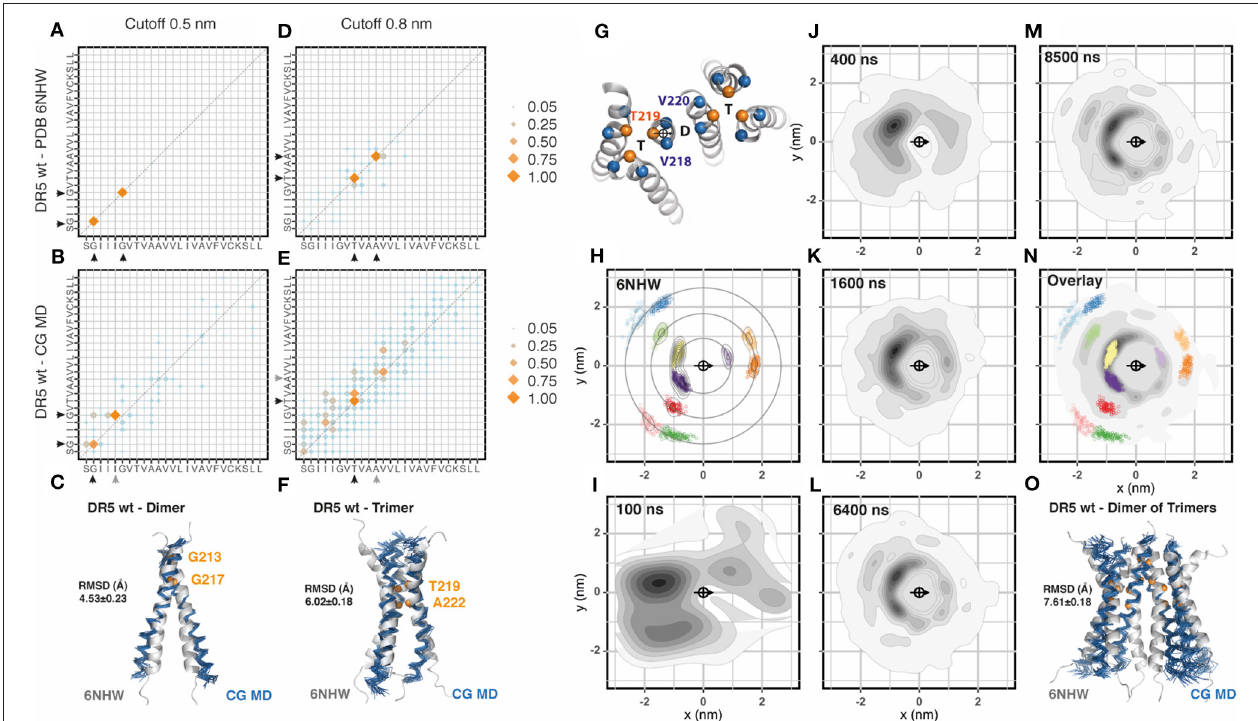
FIGURE 3 | DR5 assembly (A) . Contact matrix of DR5 NMR (PDB:6nhw) at 0.5nm cut-off distance. The amino acid sequence corresponds to residues S212 to L236. Black arrowheads indicate the residues involved in these interactions (GxxxG motif). Data corresponds to the averaged 15 NMR models. Scale corresponds to the number of contacts normalized to the most frequent one. (B) Same as (A) , for DR5 coarse grained molecular dynamic (CG-MD) simulations. Black arrowheads indicate conserved interactions whereas gray arrowheads indicate non-conserved interactions. The analysis was performed on the full system (36 × 36) between 3 and 8 µ s. (C) Alignment of DR5 NMR average dimer with a DR5 CG-MD dimer, together with the analysis of the averaged root mean square deviation (RMSD) of the alignment. (D) Same as (A) , but using a cut-off distance of 0.8nm. (E) Same as (B) , but using a cut-off distance of 0.8nm. (F) Alignment of DR5 NMR average model with a DR5 CG-MD trimer, together with the analysis of the averaged root mean square deviation (RMSD) of the alignment. (G) Residues chosen for the centroid and orientation vector used for radial distribution analysis. (H) Radial distribution analysis of coarse grained DR5 NMR structure 6nhw. Note that it is possible to identify dimers, trimers, and higher order assemblies in consecutive orbits. Scale corresponds to the 2D-density function from the scatter plot, as described in Methods. (I–M) Radial distribution analysis of different snapshots of DR5 CG-MD at the indicated time points. (N) Overlay of the radial distribution of the reference structure (6nhw, color dots) and the CG-MD structures (gray density scale). (O) Alignment of DR5 NMR average dimer of trimers with a DR5 CG-MD assembly, together with the analysis of the averaged root mean square deviation (RMSD) of the